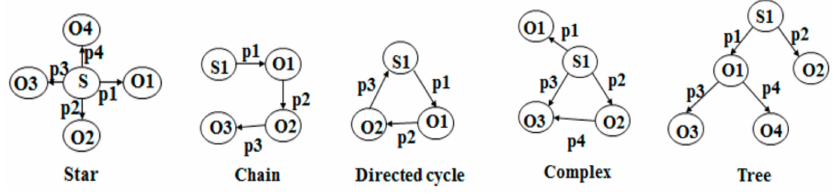
Figure 1. SPARQL query